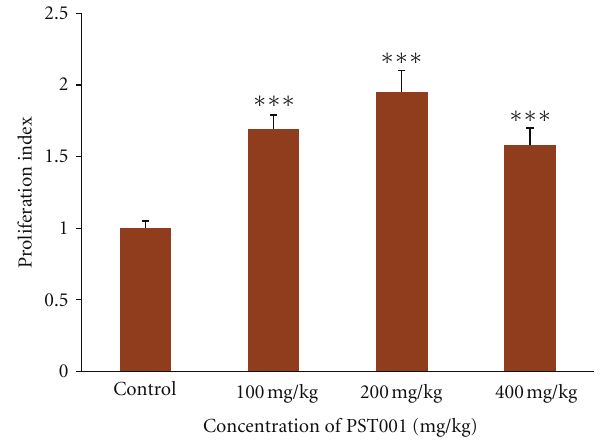
Figure 4: In vitro Lymphocyte Proliferative activity after 14 days PST001 treatment in 72 hours of incubation period. Data were expressed as mean ± SD ( n = 6). Statistically significant di ff erences are at ∗ P < 0 . 05, ∗∗ P < 0 . 01, ∗∗∗ P < 0 . 001; ns is the non- significant, as compared with control group.